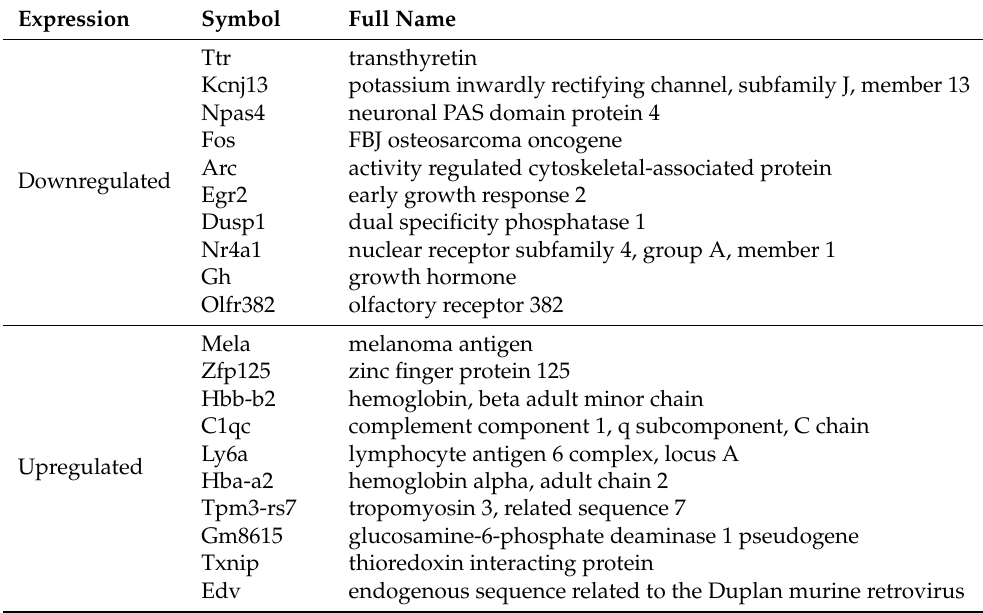
Table 2. The top 10 genes that were significantly down- or upregulated following theanine ingestion.